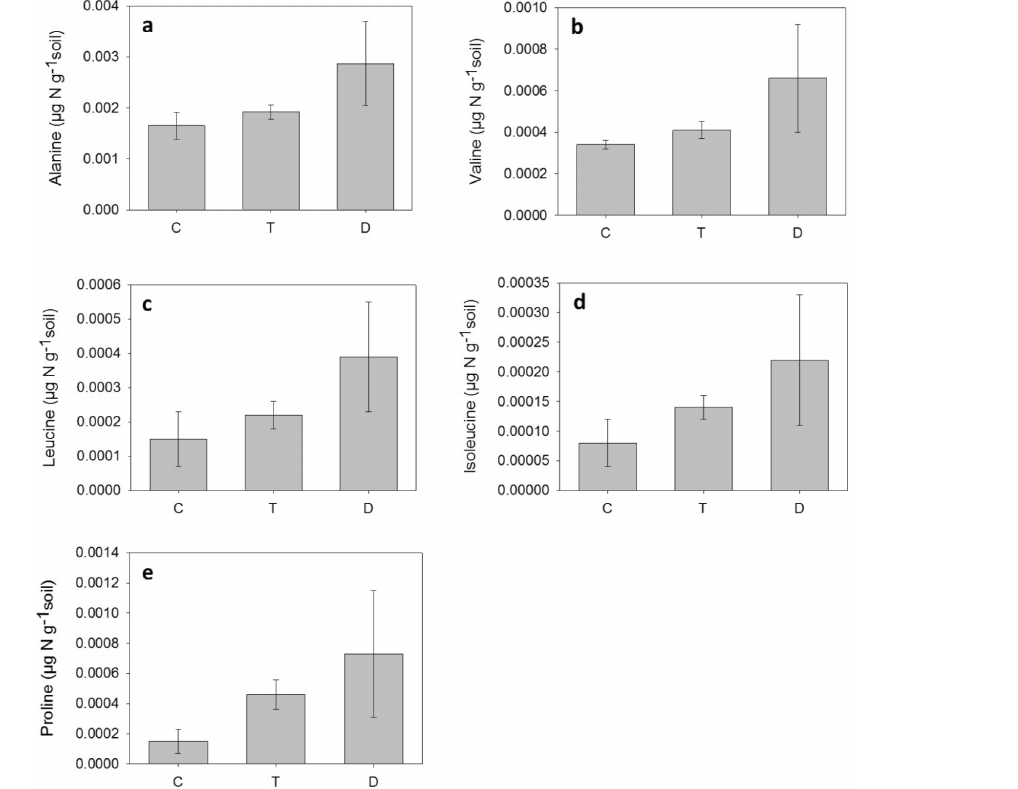
Figure 3. Initial amino acid concentrations for (a) alanine, (b) valine, (c) leucine, (d) isoleucine and (e) proline; in a heathland soil exposed to the climatic manipulations. T – warming treatment, D – drought treatment and C –